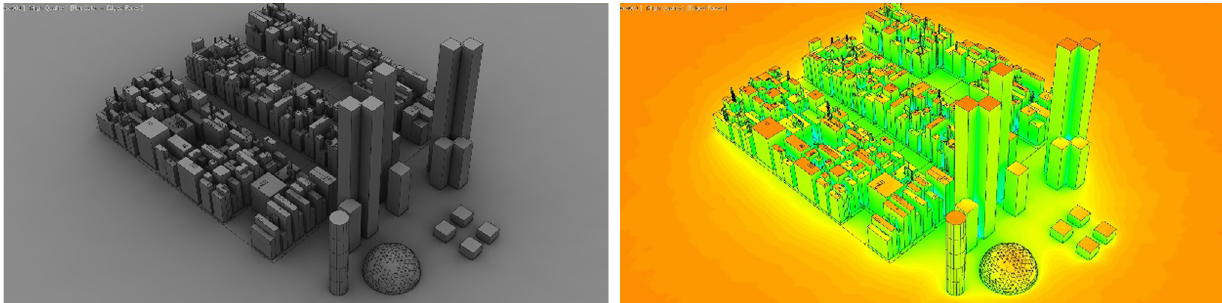
Figure 7. This figure shows screen grabs of a simple precinct model with less restrictive height limits (taller buildings) (left image) with GPU based viewport feedback for sky view factor (urban canyon) (right image).